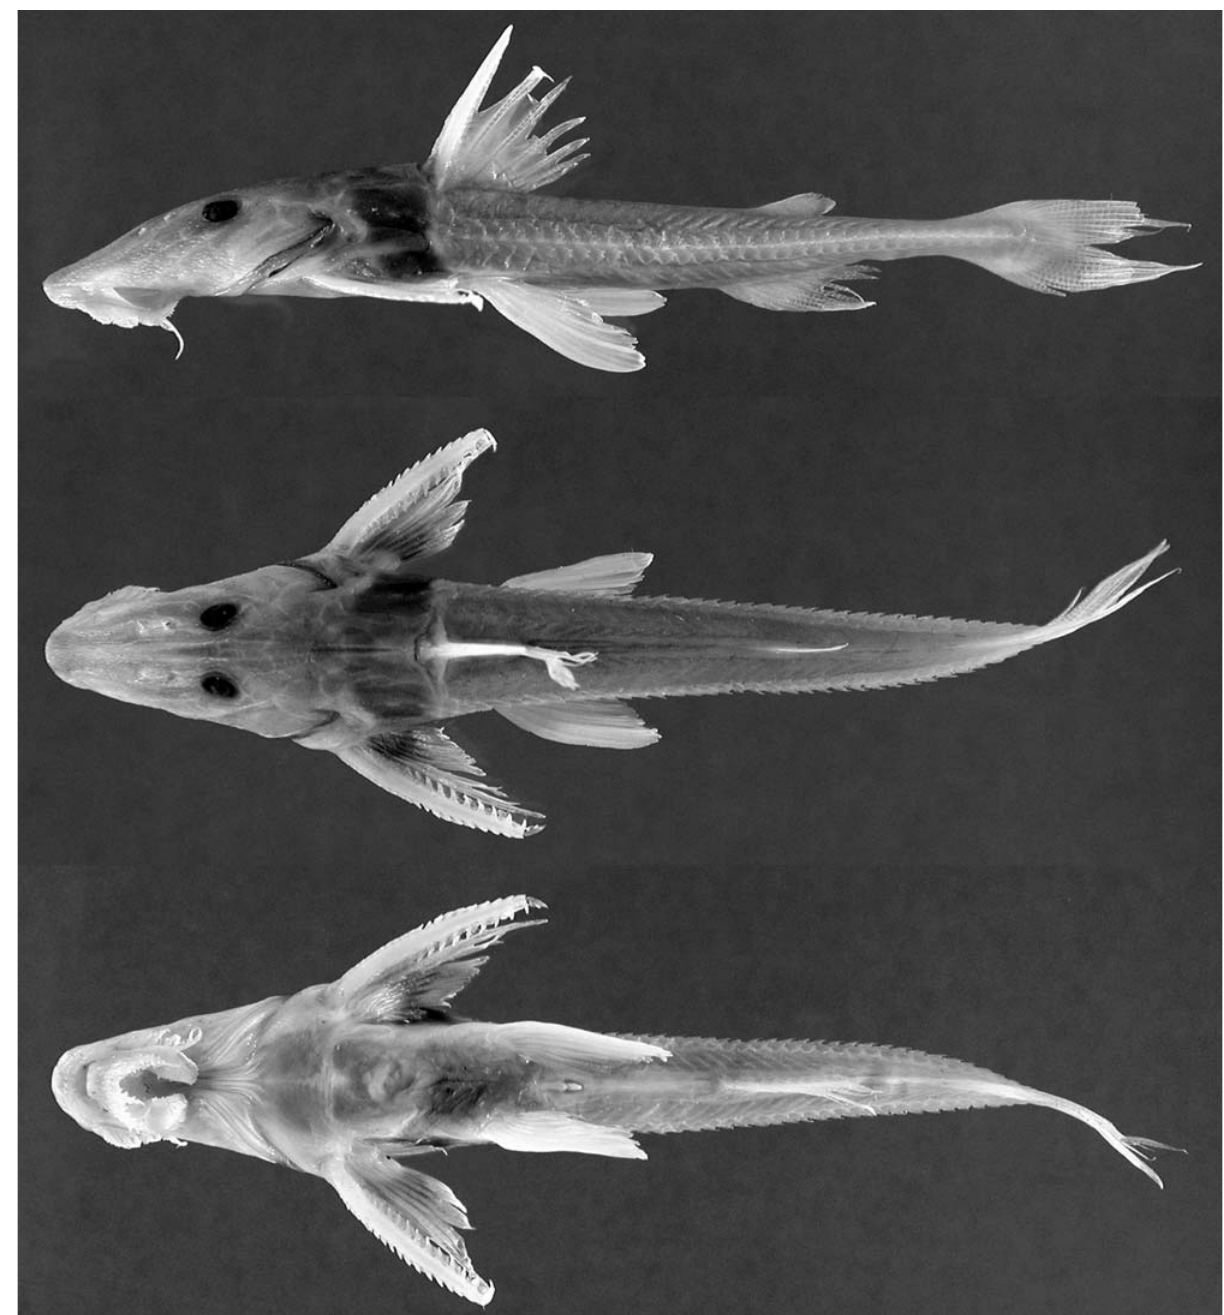
Fig. 28. Leptodoras myersi , paratype, ANSP 112319 (SL 76 mm), río Amazonas (Atlantic dr.), vicinity of Iquitos, Loreto,